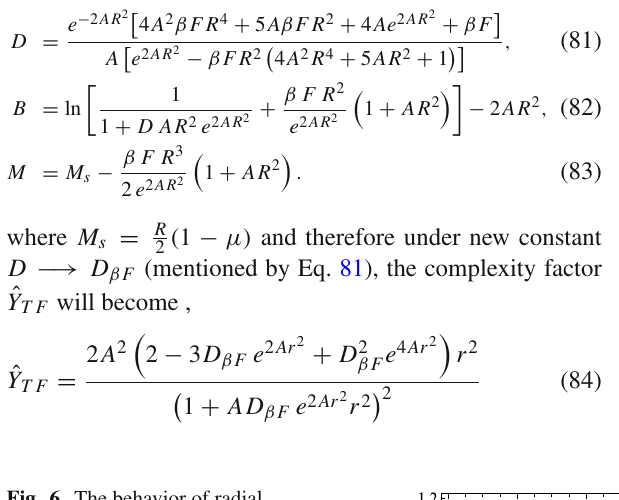
Fig. 6 The behavior of radial pressure ( P r × 10 4 )-top left, tangential pressures ( P ⊥ × 10 4 )-top right, energy density ( (cid:13) × 10 4 )-bottom left and anisotropy ( ˆ (cid:14) × 10 4 )-bottom right versus radial coordinate r / R for different coupling constant β with compactness factor M s = 0 . 25 with F = 0 . 0002. R The above figures are plotted for the anisotropic solution 4.2 corresponding to the case ˆ Y = Y TF